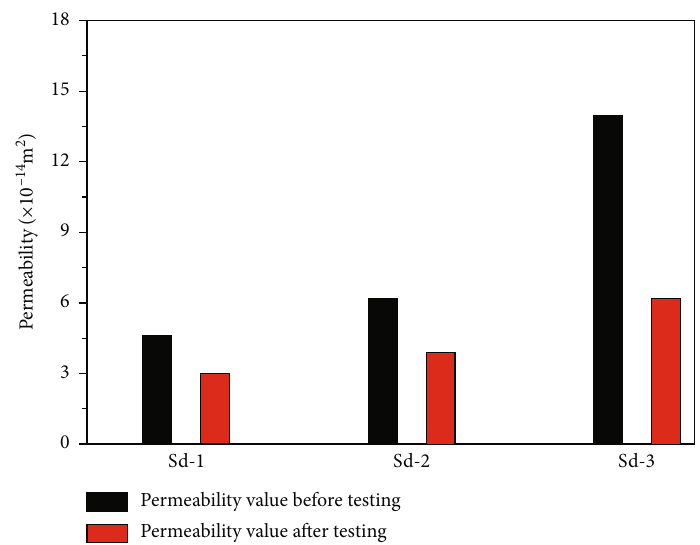
Figure 7: Permeability changes before and after testing under axial dynamic stress.